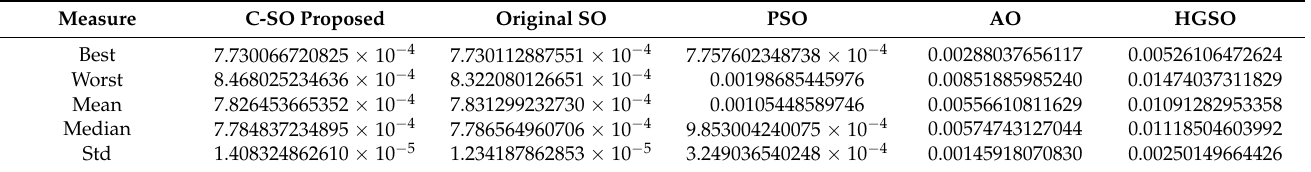
Table 3. Statistical measures for the obtained results using different algorithms over 30 independent